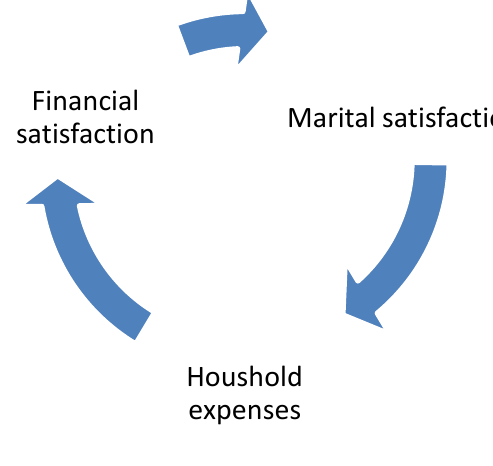
FIGURE 3: Marital problems